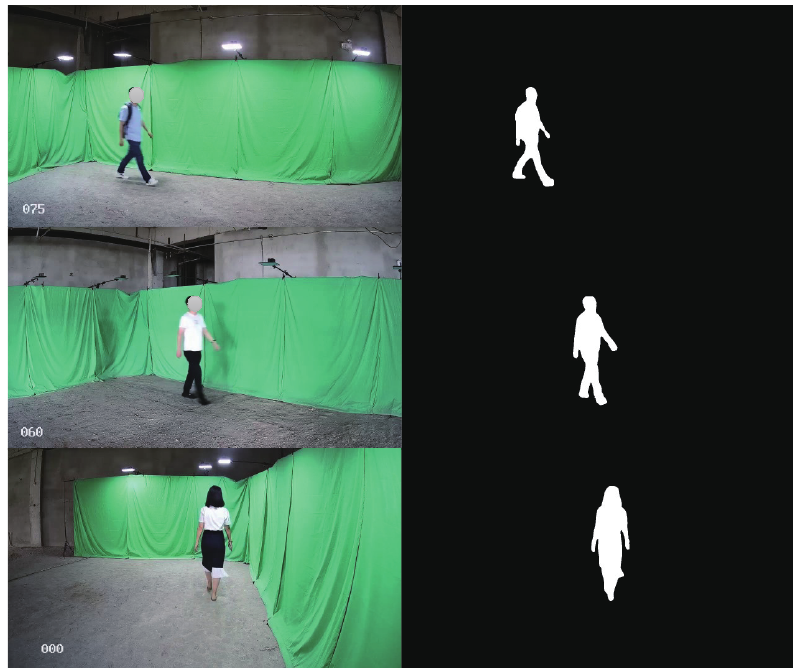
Figure 9. Illustration of the proposed Multi-state Gait dataset. The gait silhouette map was extracted by using the Mask R-CNN